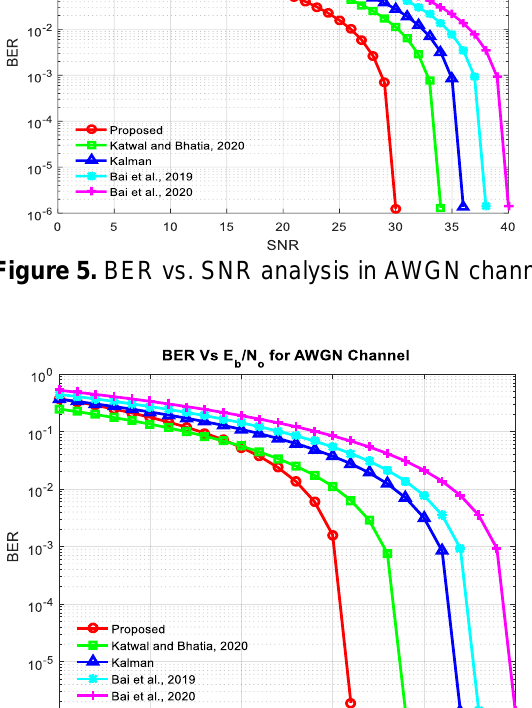
analysis for AWGN /N b 0